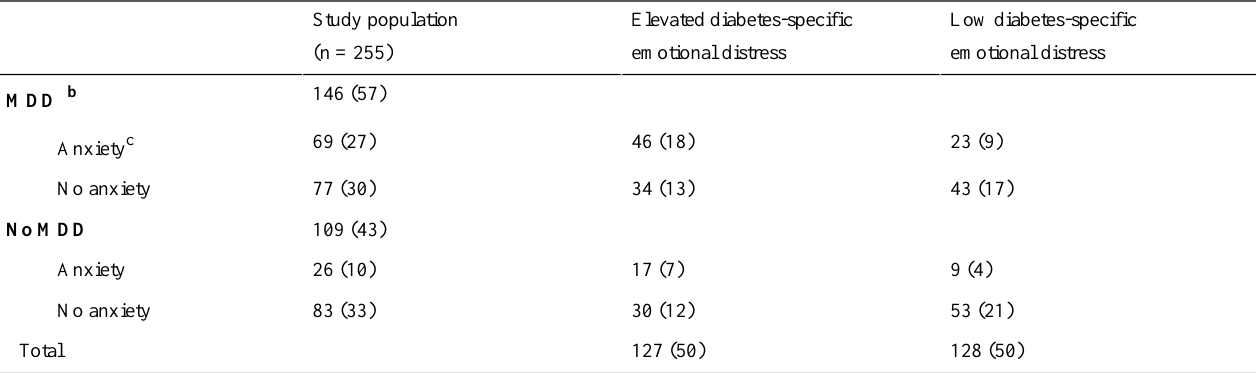
Table 2. Prevalence (%) of diagnosed depression, diagnosed anxiety disorder by elevated and low diabetes-specific emotional distress ( 40 < PAID a ≥ 40) among the study population (n =